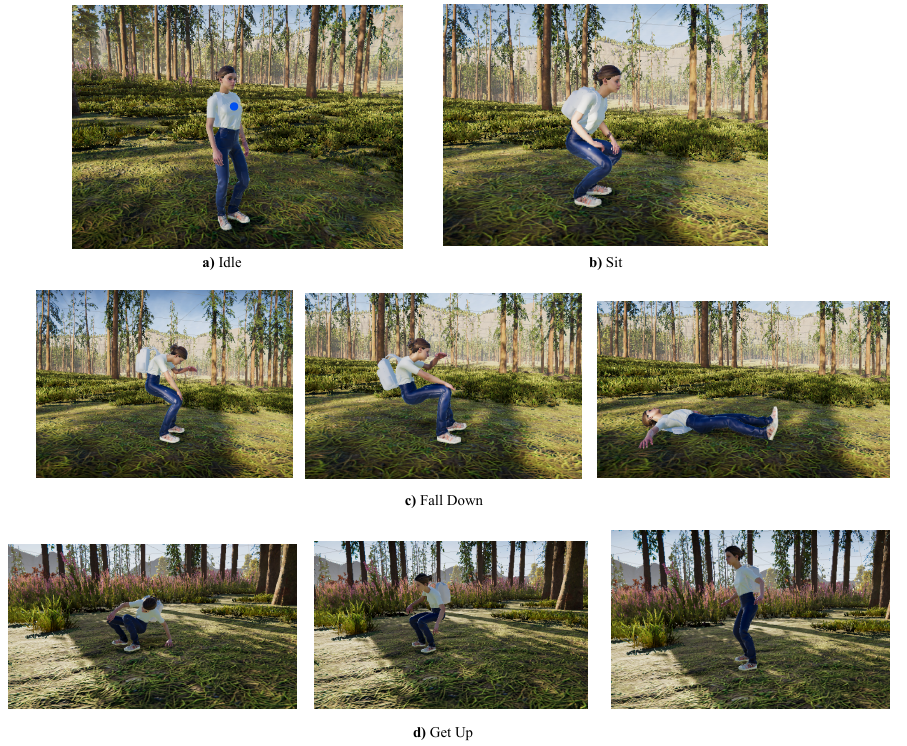
Figure 3. The avatar performs locomotive